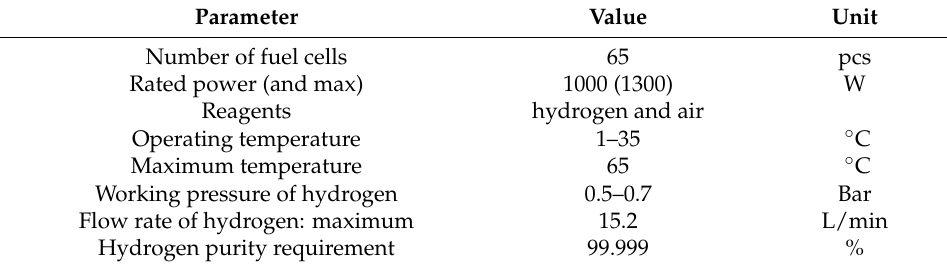
Table 3. Parameters of the AEROSTAK Horizon fuel cell stack.